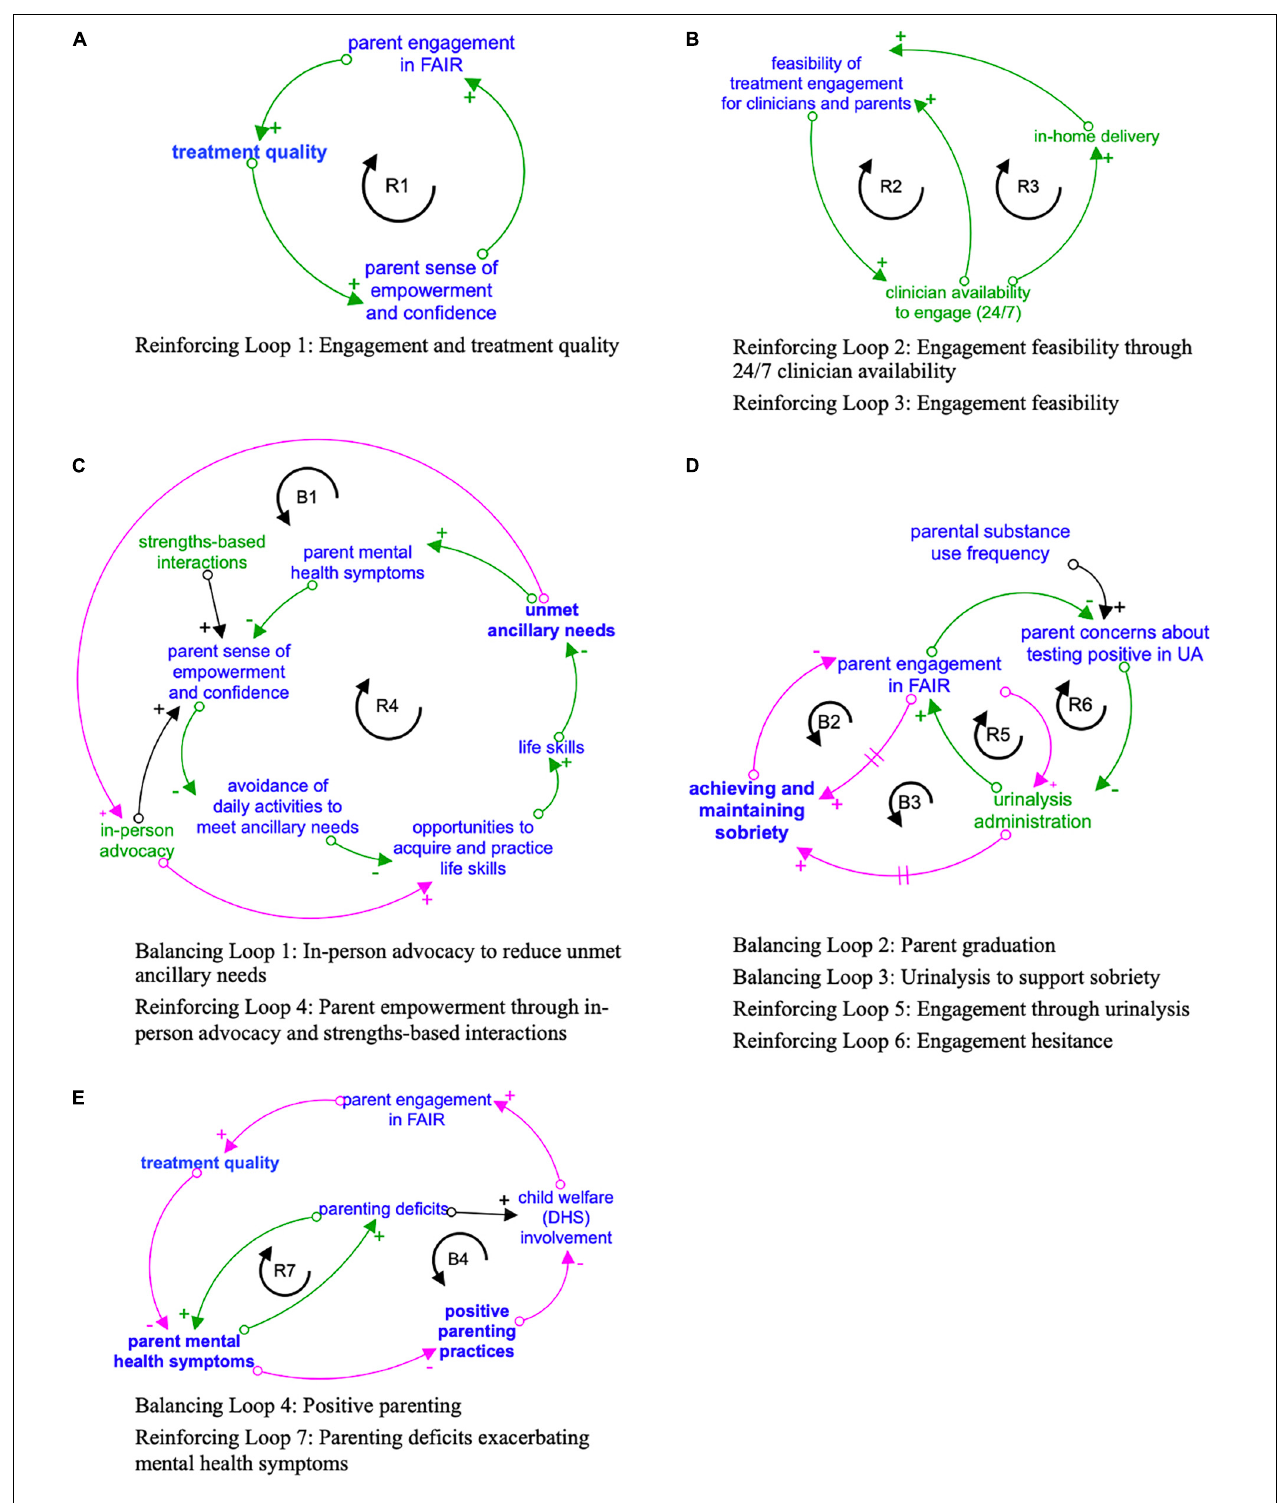
FIGURE 1 | (A-E) Key feedback loops driving the causal theory of how FAIR engagement strategies impact parent engagement and treatment goals. Engagement strategies designated in green. Outcomes related to the four primary FAIR treatment domains designated in bold. Reinforcing loops indicated in green with R clockwise arrow, and Balancing loops in pink with B counter-clockwise arrow. Arrows with a + sign indicate that the variables either both increase or both decrease when there is a change. Arrows with a – sign indicate that as one variable increases, the other decreases, or vice versa. A hashmark (two parallel lines) on an arrow represents a delay in the effect of the first variable on second